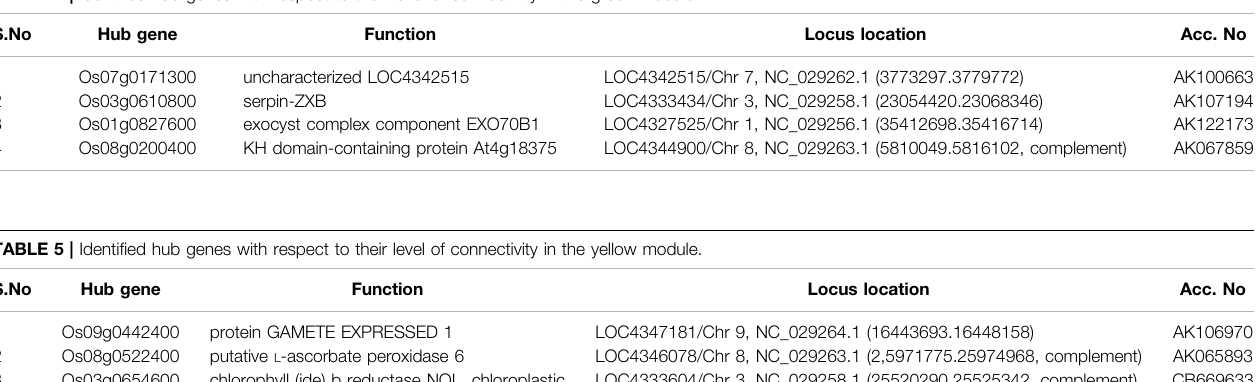
TABLE 4 | Identi fi ed hub genes with respect to their level of connectivity in the green module.